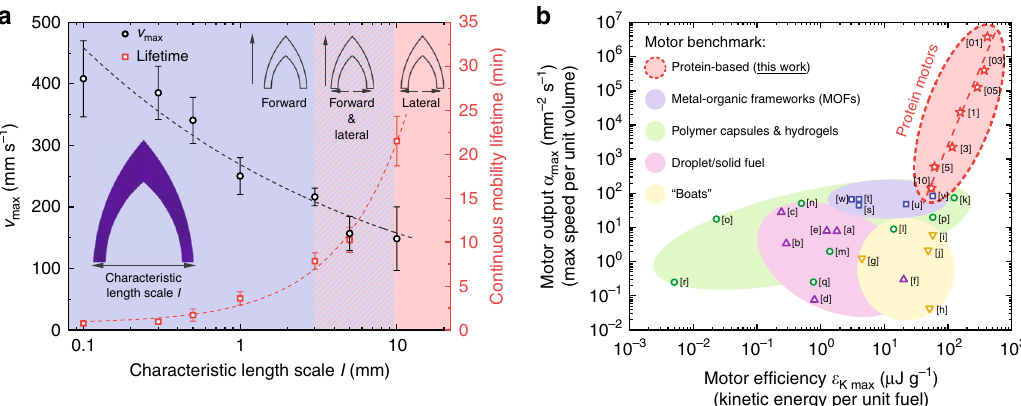
Fig. 4 Protein motor performance. a Scaling of motion speed and lifetime. Maximum speed of the motors scales with ~ l − 1/3 as described by the model (dashed line), up to a maximum speed of 408 mm s − 1 for l = 100 μ m motors. Continuous mobility scales linearly with l up to 21 min for l = 10 mm motors and a total lifetime of over 2 h. Black circles are v max , red squares are continuous mobility lifetime. Error bars represent standard deviation, n = 15. b Motor benchmark. Signi fi cant metrics for comparing performance of chemical motors are motor performance output α max (maximum speed per unit volume) and motor ef fi ciency ε K max (maximum kinetic energy per unit fuel). Protein motors outperform other chemical Marangoni motors from a diversity of materials and fuels. Red stars are protein-based motors (this work), blue squares are MOF motors, green circles are polymer motors, purple triangles are droplet/ solid fuel motors, yellow inverted triangles are boat motors. Full references are given in Supplementary Table